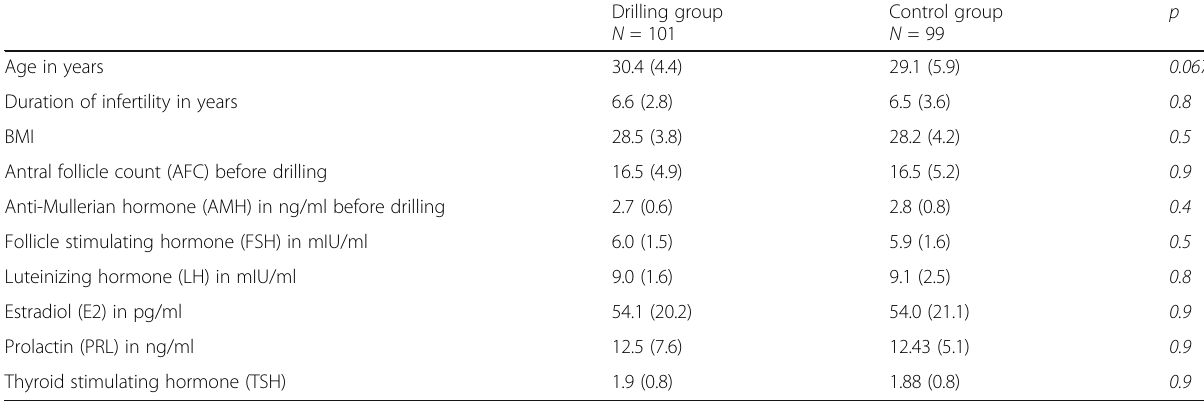
Table 1 Baseline